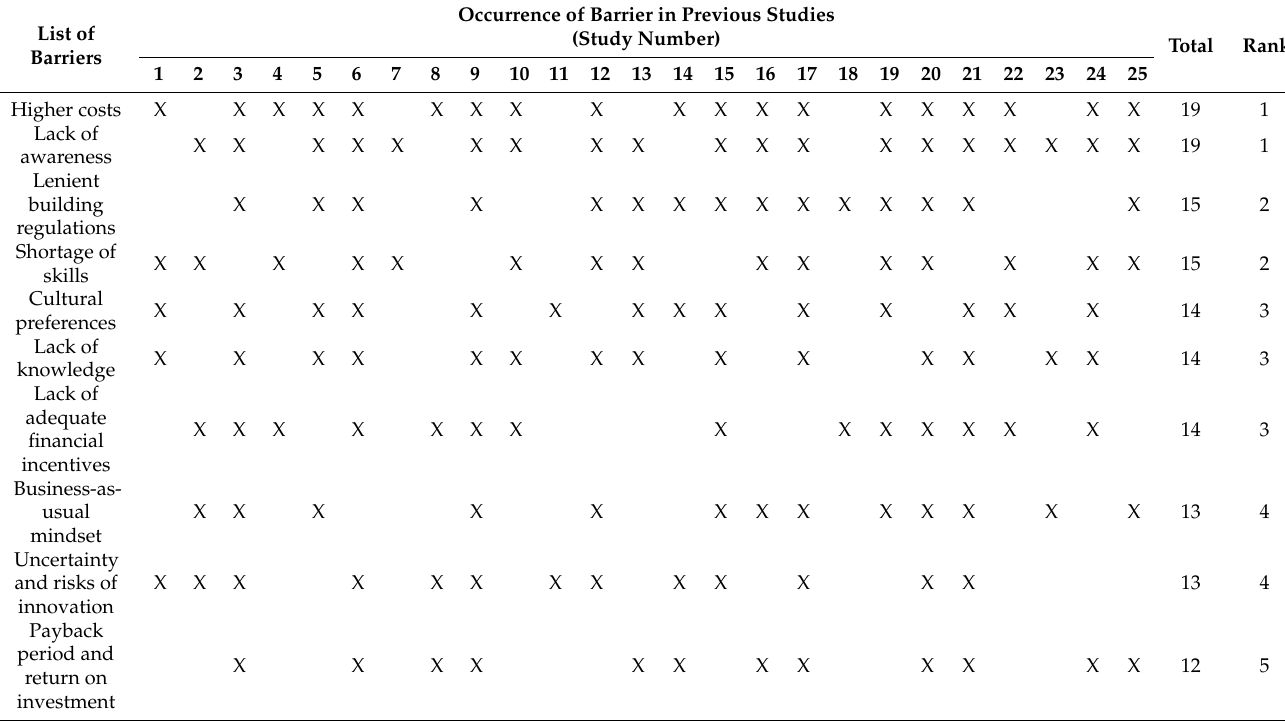
Table 2. Most common barriers identified in literature (adapted from